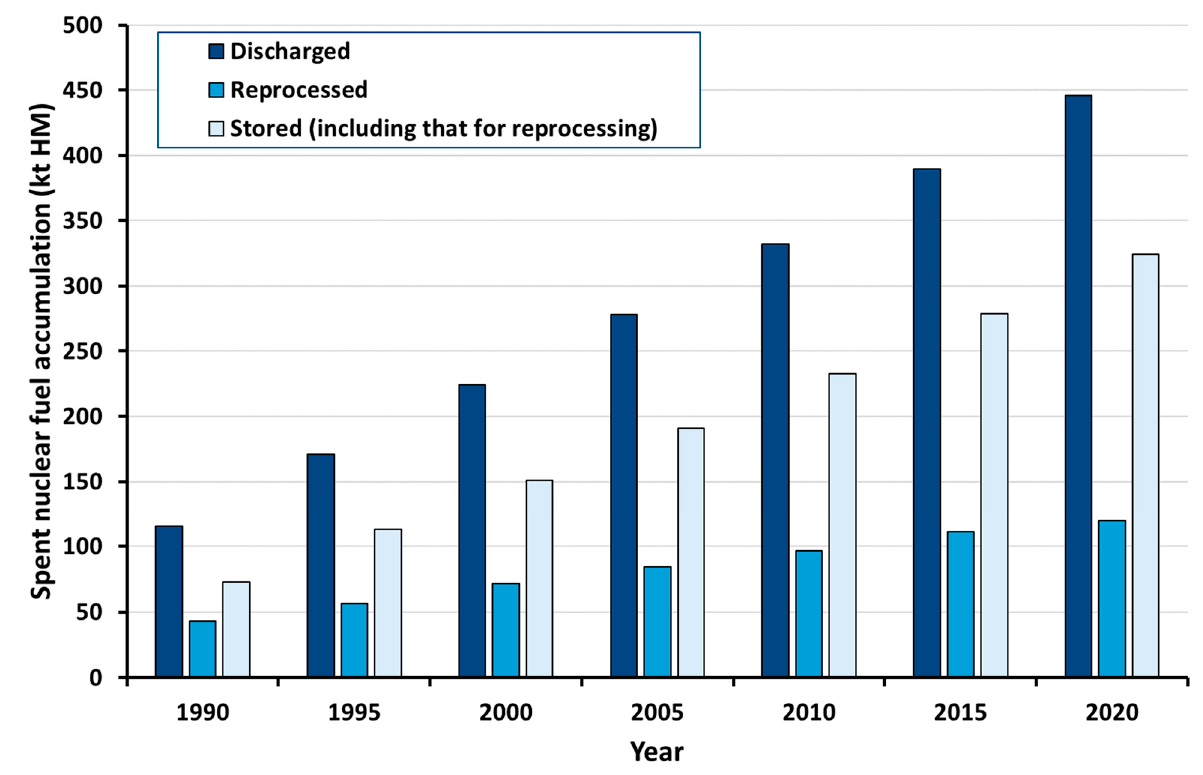
Figure 2. Global spent fuel accumulation. Redrawn from data in [32].